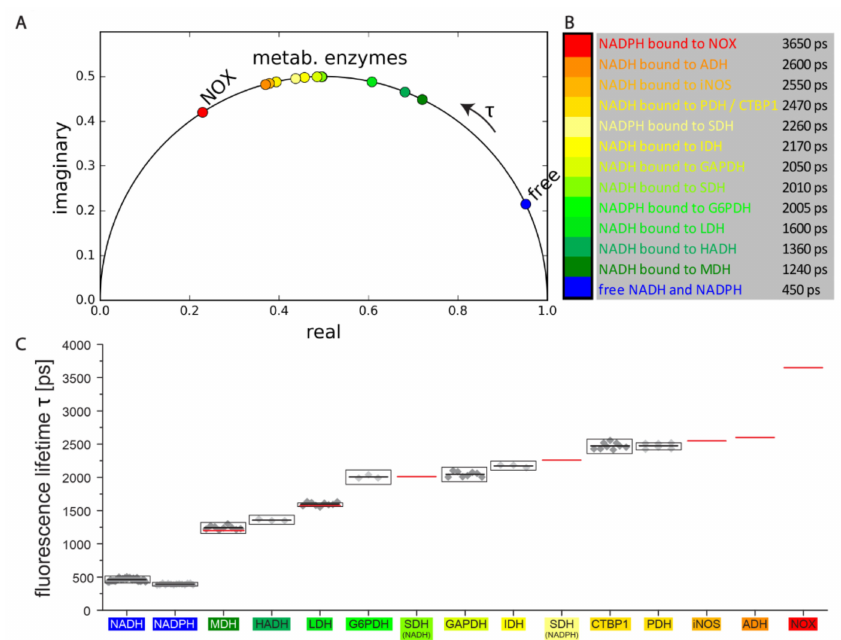
Figure 2. Reference system of NADH and NADPH fluorescence lifetimes and phase vectors in the free and enzyme-bound state. ( A ) Phasor plot with the positions of the coenzymes NADH and NADPH fully bound to the identified relevant, abundant NAD(P)H-dependent enzymes, as chosen by from RNA sequencing data. The positions on the plot have been either determined as described for NADH and MDH in Figure 1B from our experimental FLIM data on mixtures of coenzyme and pure enzyme or calculated from our previously published data on such mixtures. The arrow outside the half-circle shows the direction in which the fluorescence lifetime τ increases. ( B ) List of measured fluorescence lifetimes τ 2 of NADH or NADPH fully bund to enzymes. ( C ) The fluorescence lifetimes in panel (B) were determined as described in Figure 1B, fluorescence lifetimes calculated from single images represented as gray dots, average values as black lines, standard error of the mean (s.e.m.) values over all pixels in all measured images per coenzyme / enzyme mixture as black boxes. The list was completed by our previously measured fluorescence lifetimes [6] measured for NADH and NADPH bound to SDH, NADH bound to iNOS, NADH bound to ADH, and NADPH bound to enzymes of the NOX family (red lines). For LDH and MDH the literature data of other groups are indicated as red lines. The color coding in panels (A–C) is